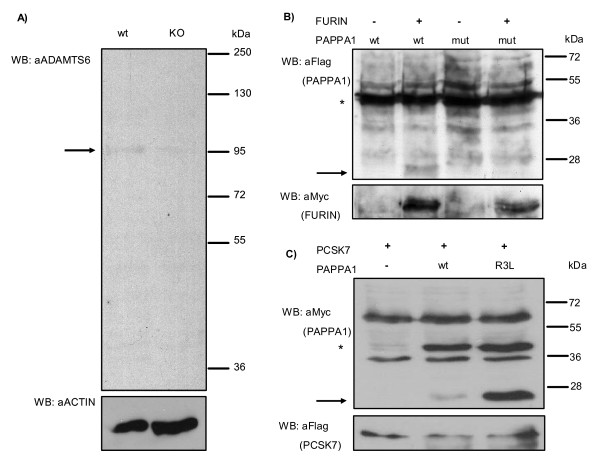
Proteolytic processing of ADAMTS6 and PAPPA1. A) Aliquots of CD4+ T cell lysates from wild-type and FURIN knock-out mice were run on SDS-PAGE and ADAMTS6 and ACTIN were detected by Western blot. B and C) 293e cells were transfected with FURIN-myc-his or PCSK7-flag together with wild-type, PCSK cleavage site mutated flag-PAPPA1-myc (mut) or PCSK7-favored leucines harboring flag-PAPPA1-myc (R3L) constructs, and detected anti-flag or anti-Myc antibodies as indicated. Unprocessed PAPPA1 is indicated with an asterisk and processed with an arrow. All experiments were repeated at least twice with similar results.